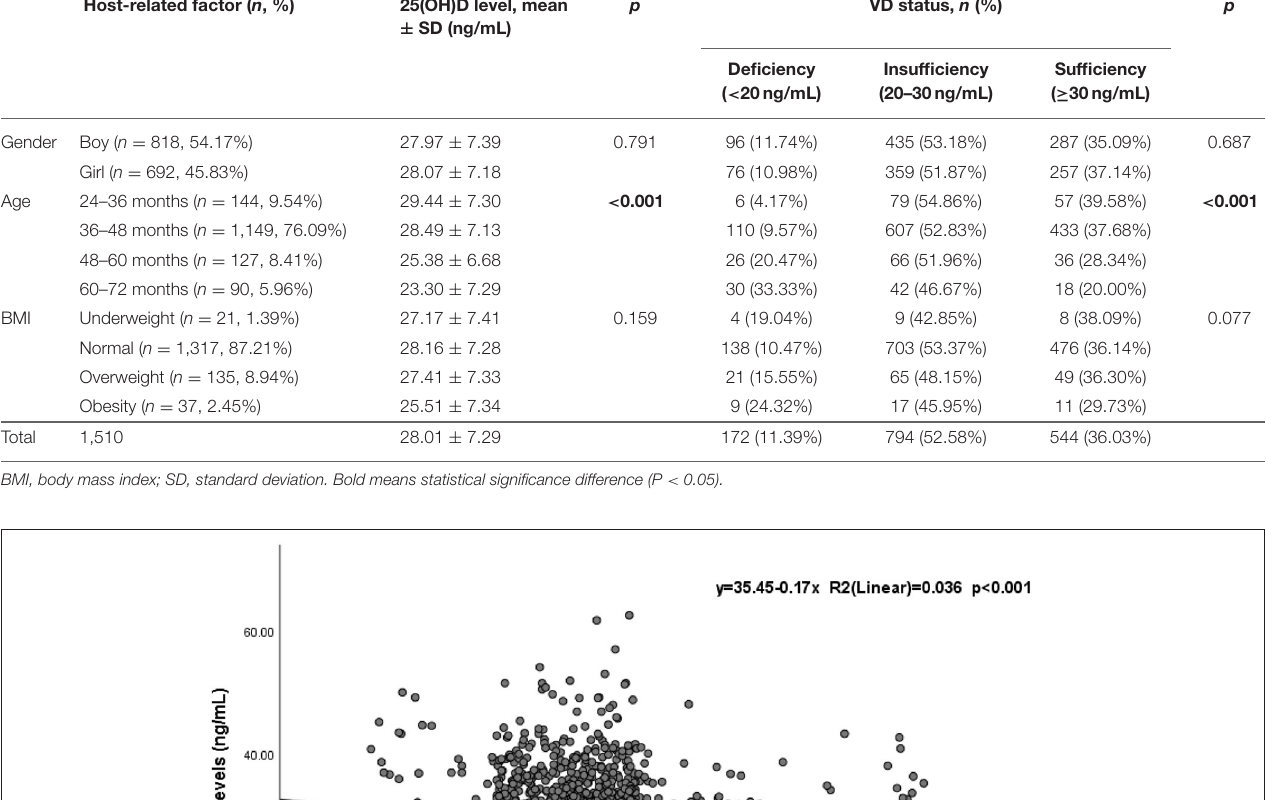
TABLE 1 | The influence of host-related factors (gender, age, BMI) on serum 25(OH)D levels and vitamin D status in children. Host-related factor ( n , %)